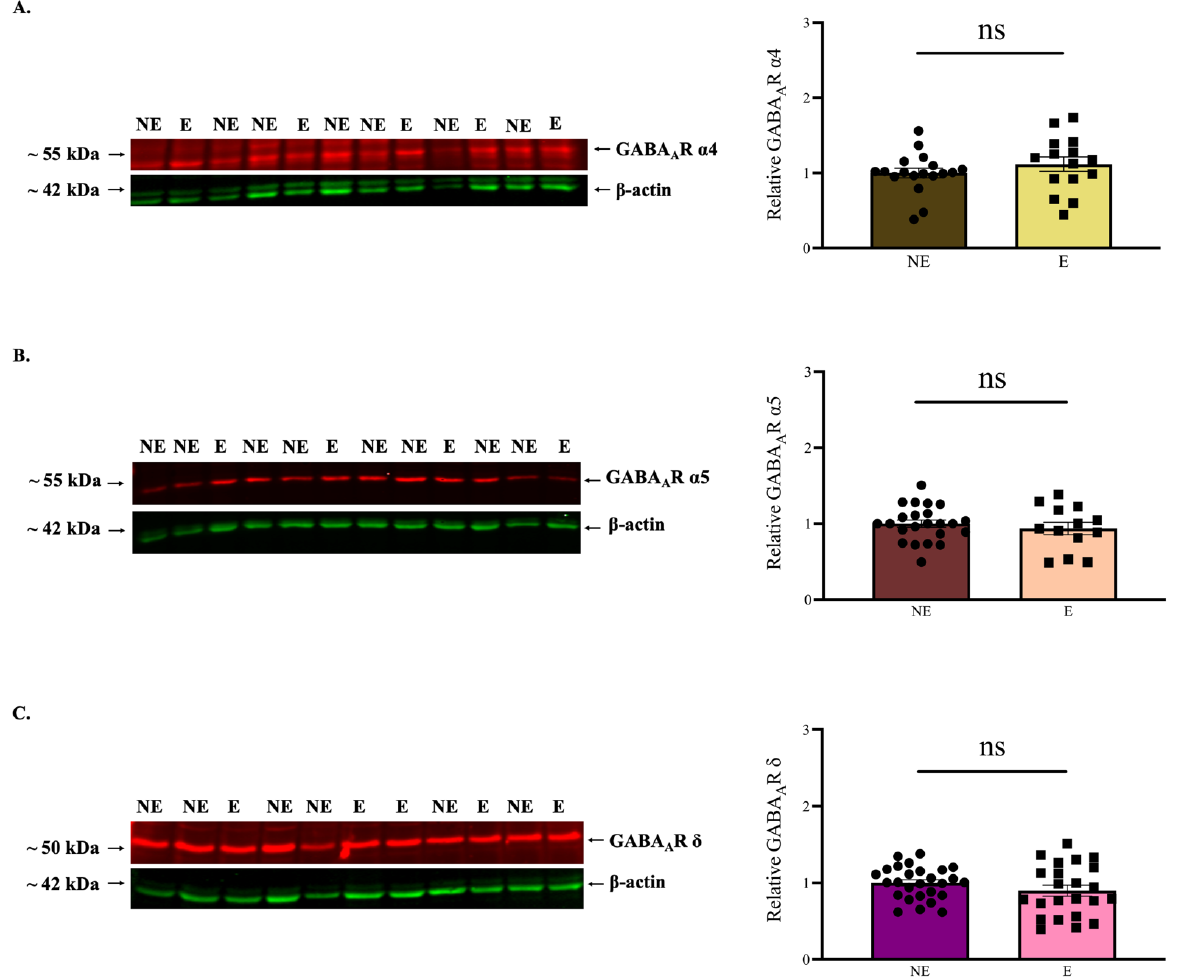
Figure 5. WB analysis for the principal tonic GABA A R α 4, α 5, and δ subunits. Analysis compares the primary SoCx of control (NE) littermates and the epileptic (E) stargazers. ( A – C ) Representative blots display tissue expression of GABA A R α 4, α 5, and δ subunits in the primary SoCx with β -actin as the loading control. Bar graphs represent the relative expression levels of GABA A R α 4, α 5 and δ subunits, respectively. Bar graphs reveal a lack of statistically significant change in whole-tissue primary SoCx expression levels for GABA A R α 4 (NE: 1.000 ± 0.063 [ n = 18], E: 1.117 ± 0.095 [ n = 15]; p = 0.325), α 5 (NE: 1.000 ± 0.048 [ n = 23], E: 0.937 ± 0.083 [ n = 13]; p = 0.672), and δ (NE: 1.000 ± 0.041 [ n = 27], E: 0.899 ± 0.069 [ n = 23]; p = 0.215). The significance threshold was set at 0.05. ‘ns’ indicates no significant change found from